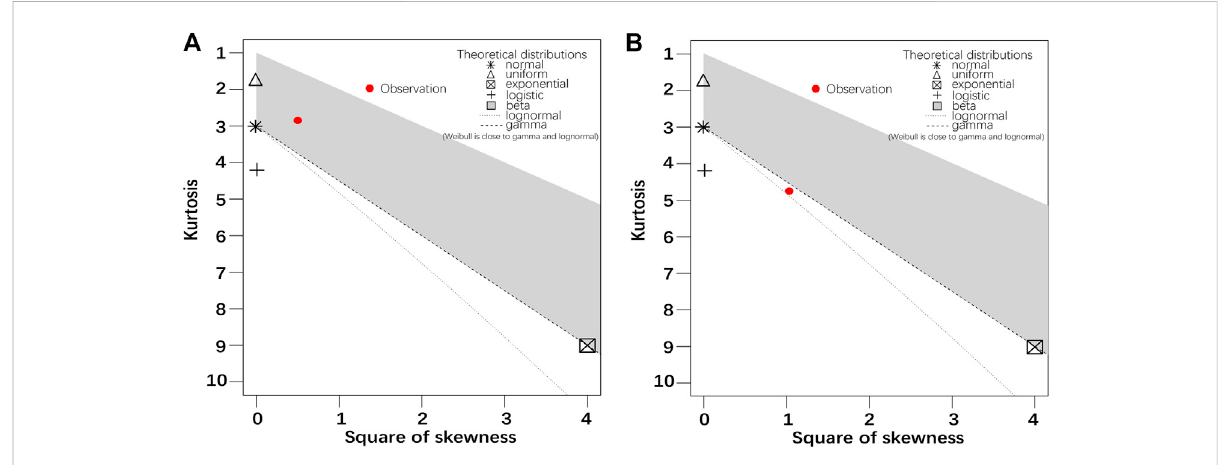
FIGURE 3 Cullen and Frey maps of (A) source 2 and (B) source 3.